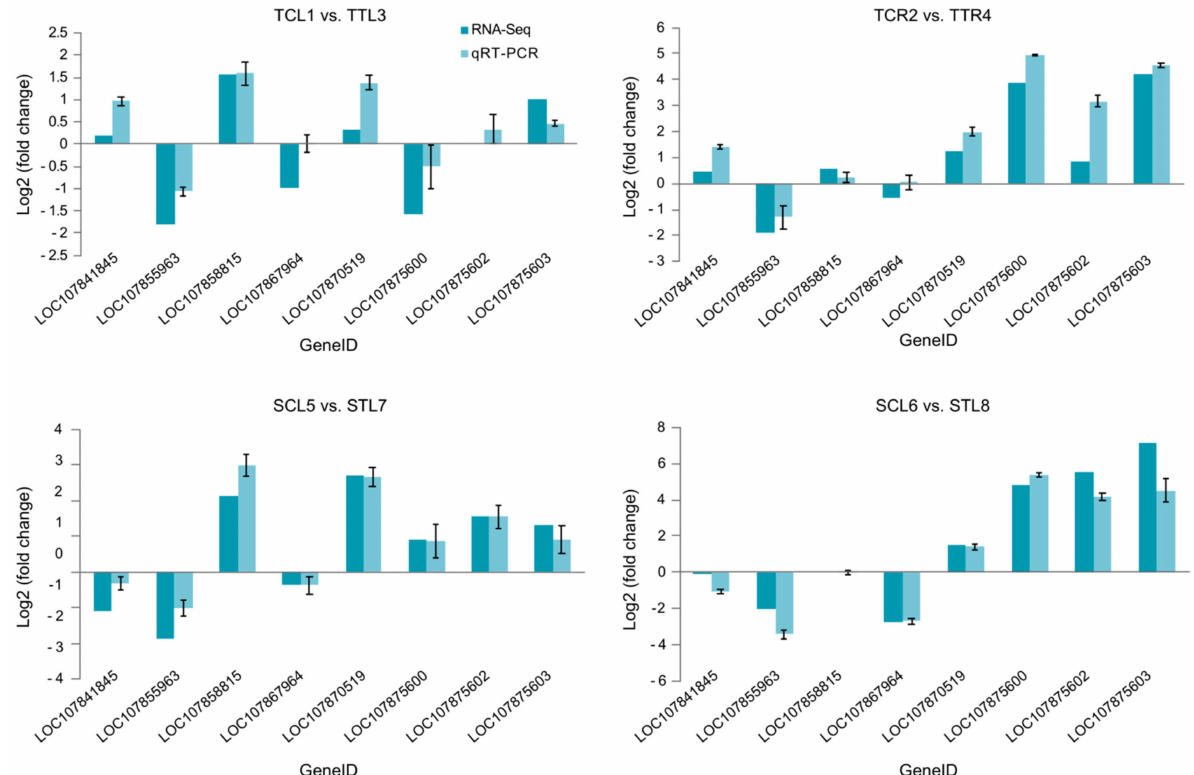
Figure 3. RNA-Seq results confirmed by qRT-PCR. A total of eight genes ( LOC107841845 , LOC107855963 , LOC107858815 , LOC107867964 , LOC107870519 , LOC107875600 , LOC107875602 , and LOC107875603 ) were examined by qRT-PCR. The pepper actin gene (AY572427) was used as an internal